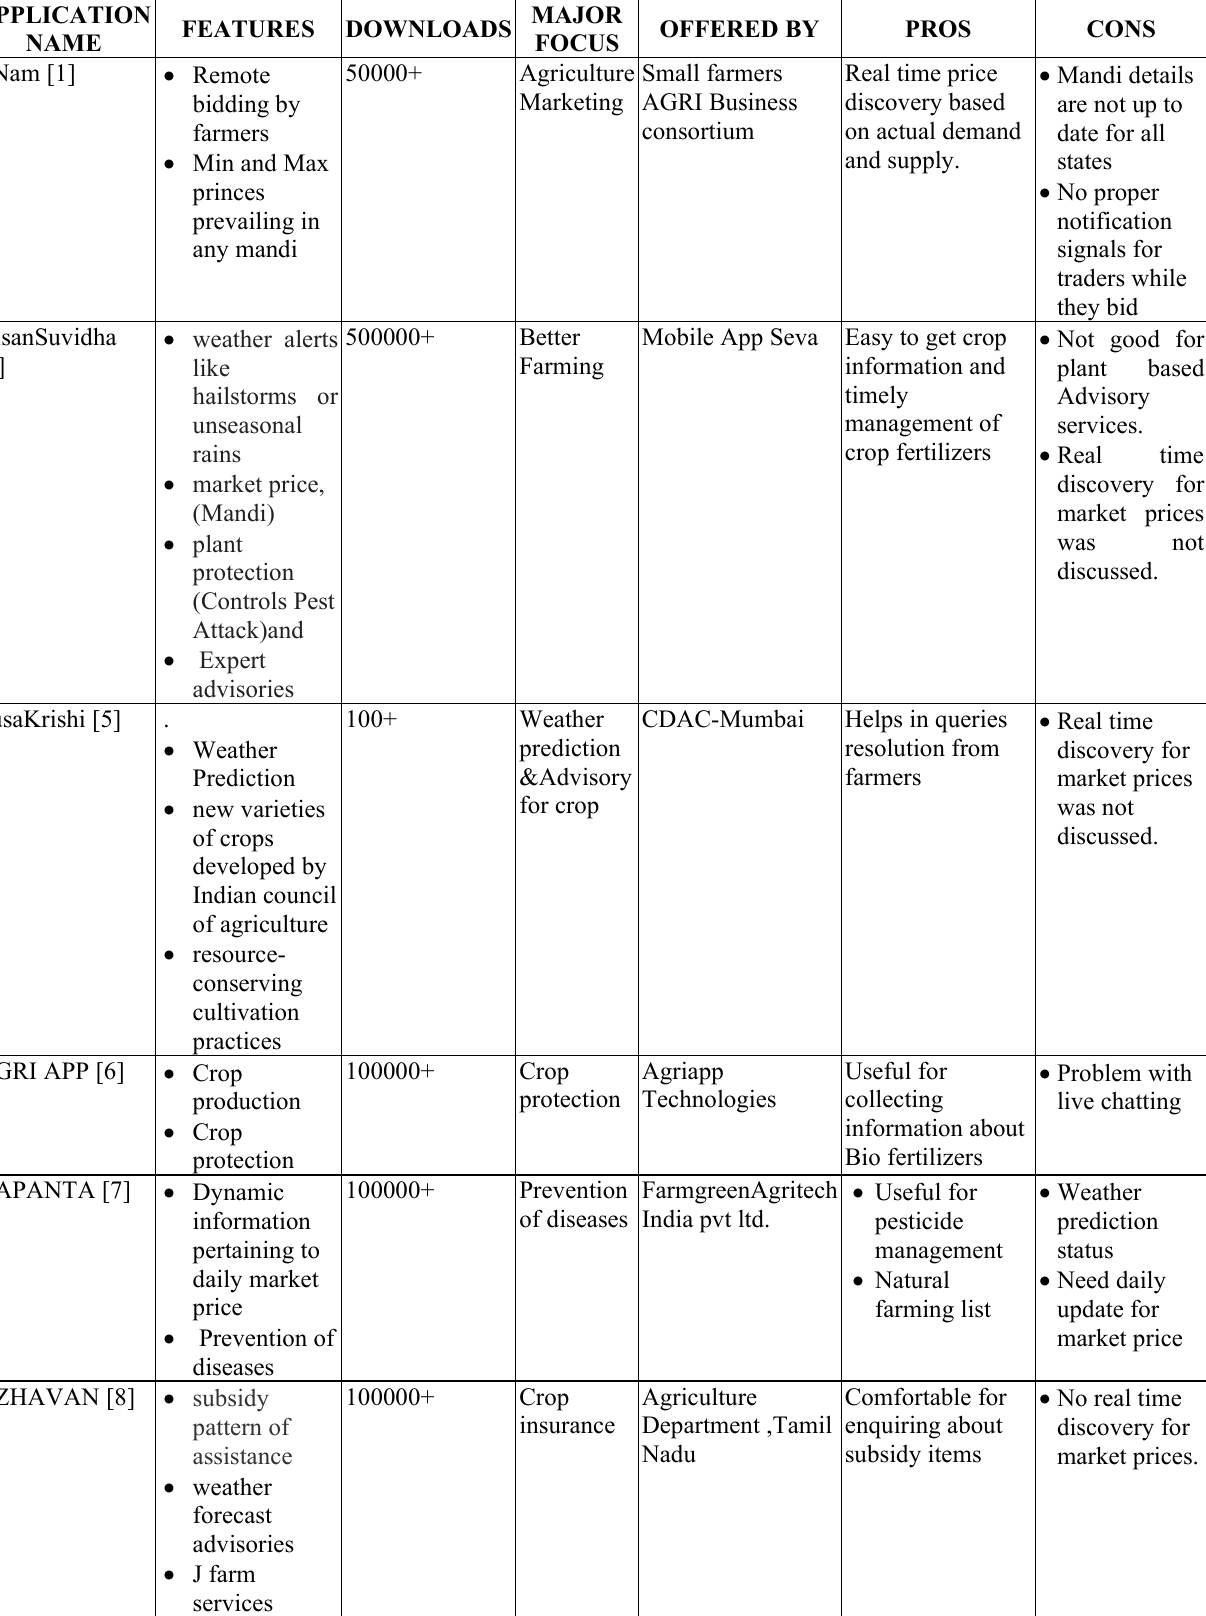
Table 1. Existing mobile applications for